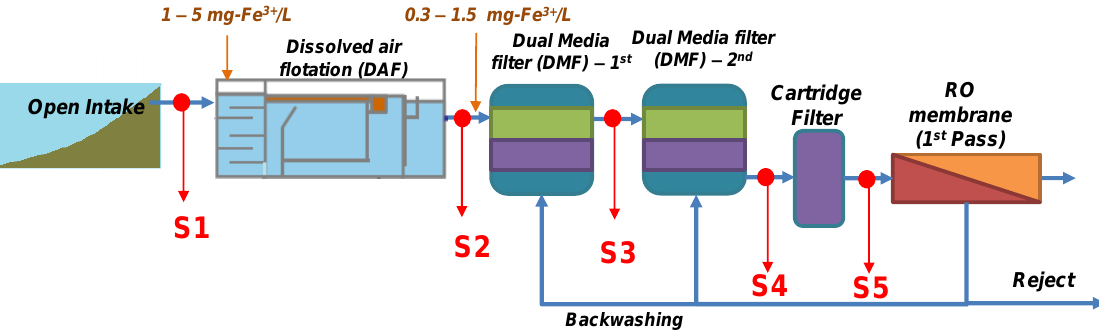
Figure 1. Schematic of the seawater reverse osmosis (SWRO) desalination plant with added coagulant dosage during the tested period (July–December). Table 1. Characteristics and operational properties of the two stage dual media filtration (DMF).